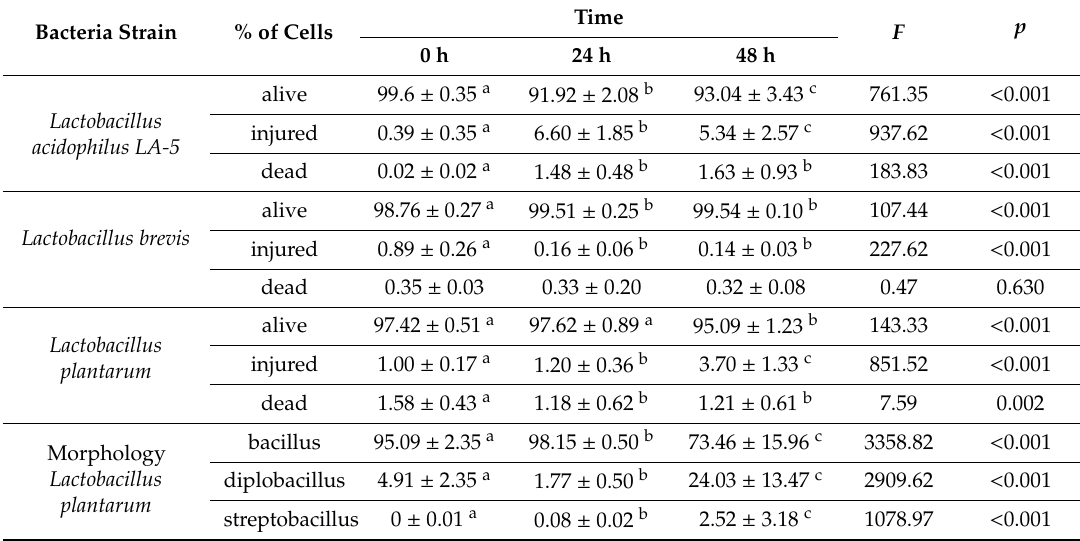
Table 2. The main e ff ect of incubation time: impact of time on percentage of specific cell types, regardless of AA